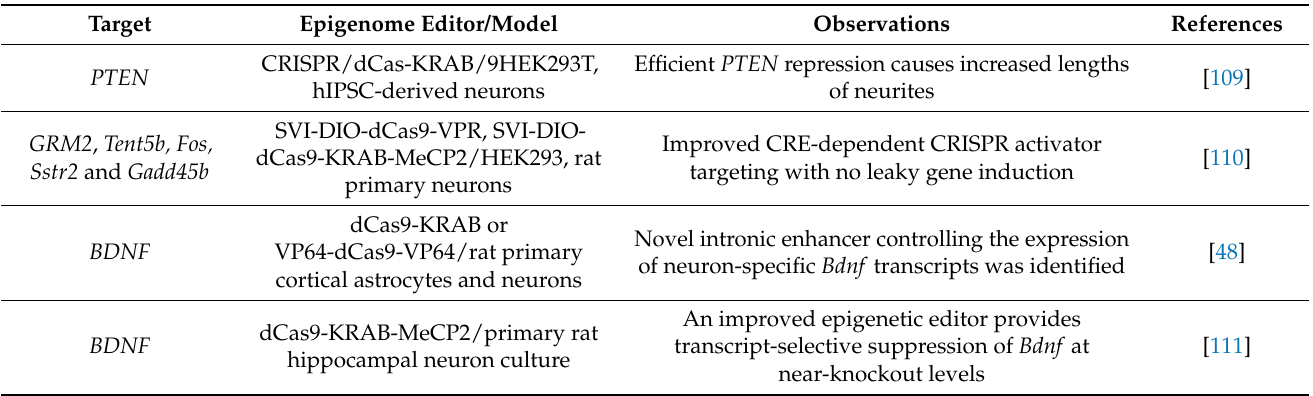
Table 2. CRISPR/Cas9 epigenetic editors are used to study and correct abnormal expression of SZ and other NDDs risk